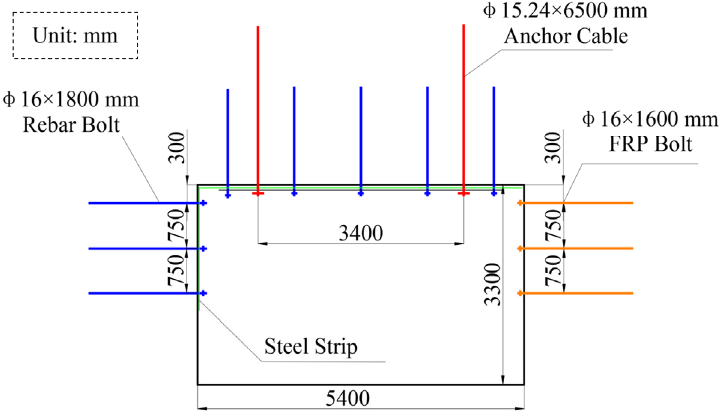
Figure 11. Optimized support design.